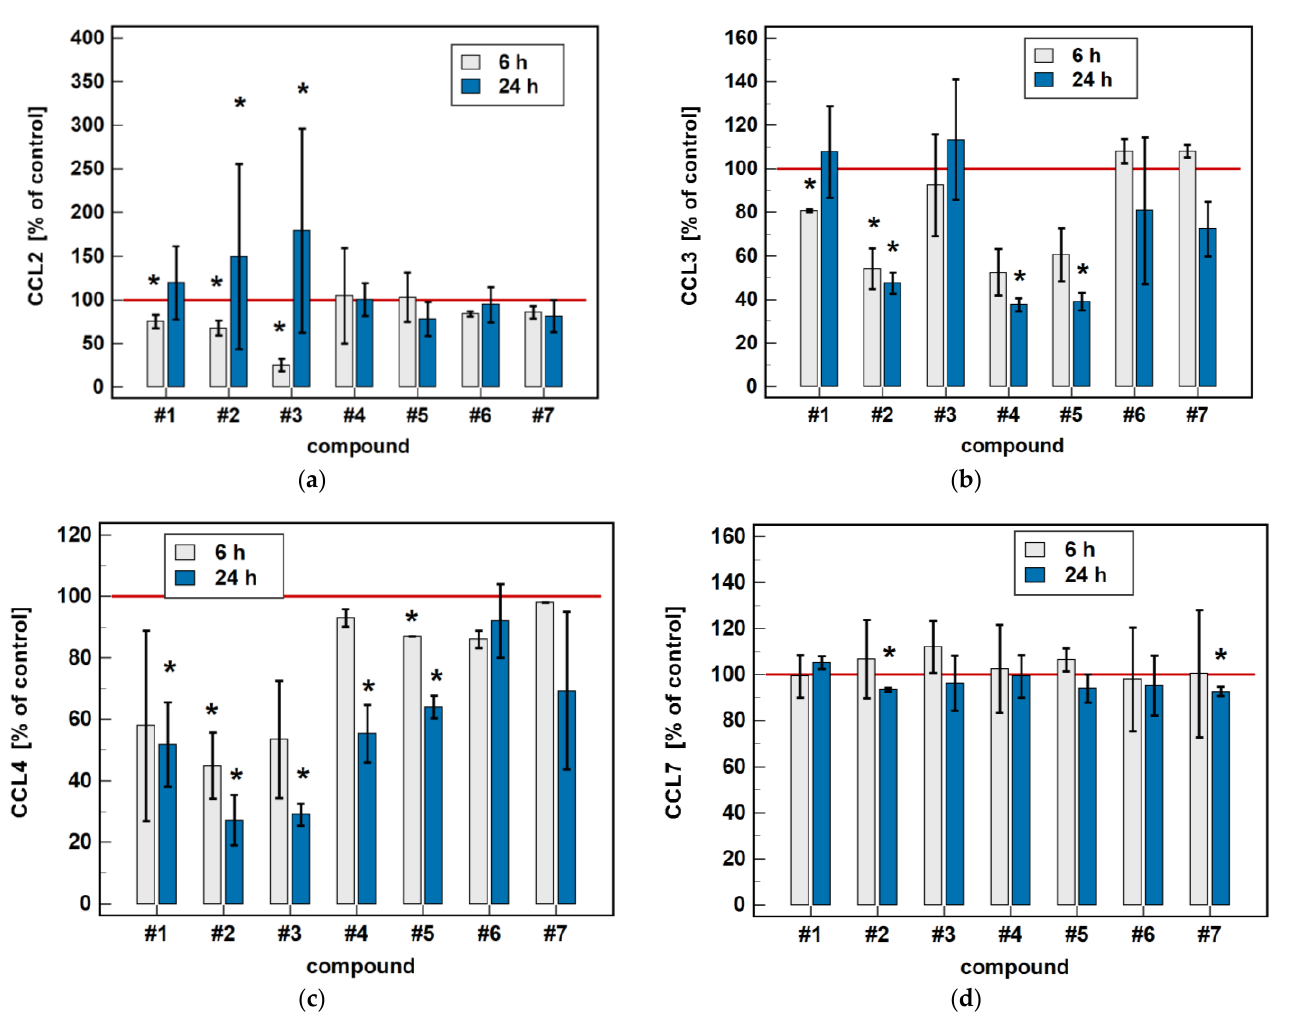
( b ) Figure 6. Dose-dependent effect of oxicams on MCP and MIP expression in HCT 116 cells: ( a ) CCL3 ; ( b ) CXCL2 . The bars and whiskers represent the mean ± SD expression ratio of the normalized relative quantities [NRQ] obtained for cells treated with 5, 50, and 200 μM oxicams for 24 h, and the corresponding untreated controls (treated -to-untreated [T/U] ratio). The significant differences between the expression in treated and untreated cells, analyzed using a t -test for paired samples, are indicated by asterisks (*). No fold-change (T/U = 1) is indicated by a red solid reference line, and five-fold upregulation (T/U = 5) or downregulation (T/U = 0.2) is indicated by an orange dashed reference line. Compound # 6 de- notes piroxicam, and # 7 denotes meloxicam. Compounds # 1 to 3 had a stimulatory effect on CXCL2 expression. The 5 μM dose was slightly inhibitory in the case of compound # 1 (1.5-fold), and had no impact in the case of compounds # 2 and # 3 . In turn, the 50 μM dose was significantly stimulatory for all of these compounds (2.7-, 3-, and 4.7-fold, respectively) (Figure 6). 2.3. Effect of Oxicams on MCP and MIP Secretion by Caco-2 Cells The oxicam effect on MCP and MIP chemokines at the protein level was tested on Caco-2 cells. The concentrations of MCP-1/CCL2, MIP- 1α/CCL3, MIP - 1β/CCL4 and MCP - 3/CCL7 released into the medium were simultaneously determined using Luminex xMAP